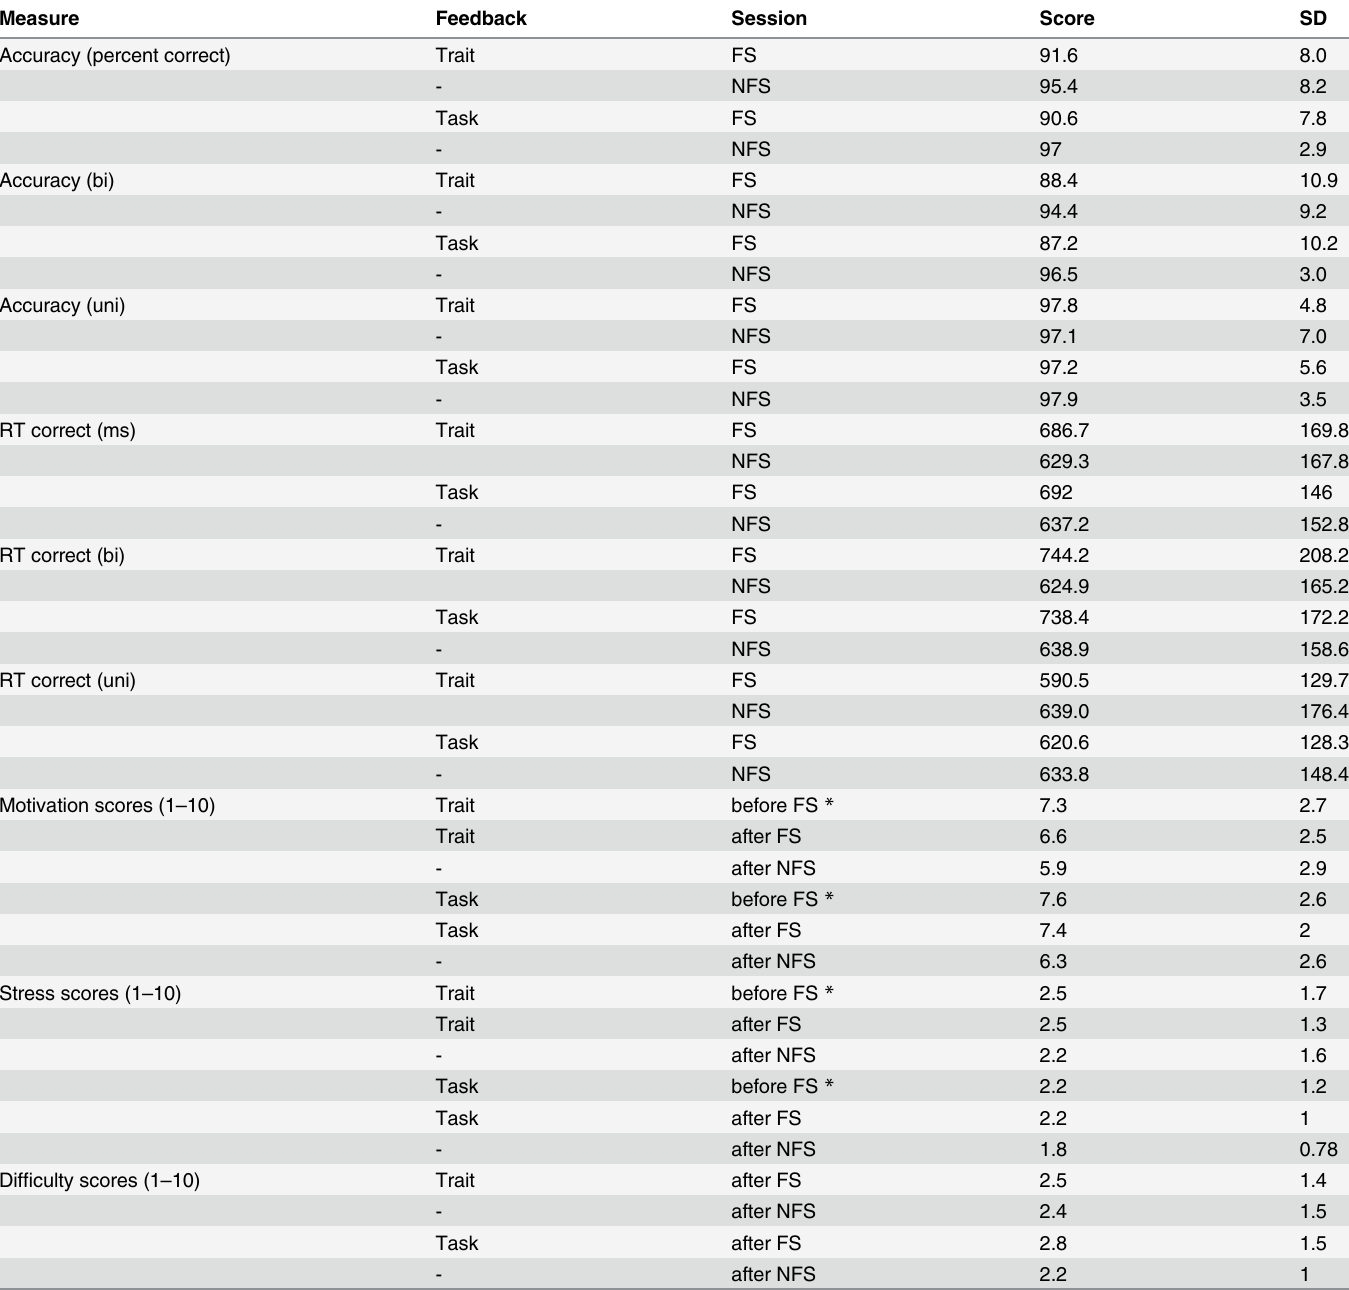
Table 1. Behavioural